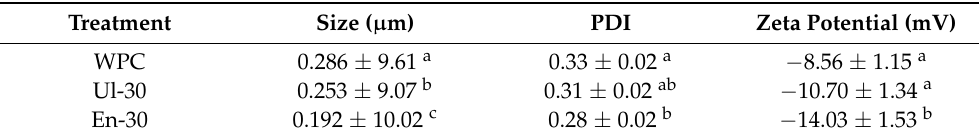
Table 2. Mean droplet size, PDI, and zeta potential of emulsions stabilized with WPC and its modified